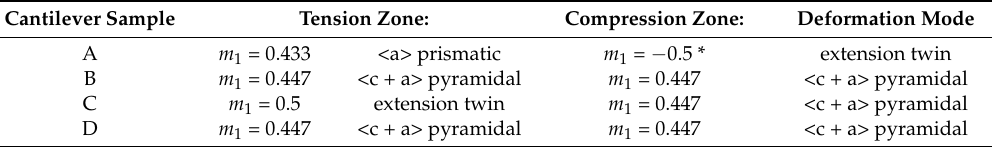
Table 3. The largest Schmidt factors m 1 calculated according to a past paper [26] on the condition of neglecting all the stress components except tension/compression and the corresponding slip/twinning systems for either zone of each cantilever